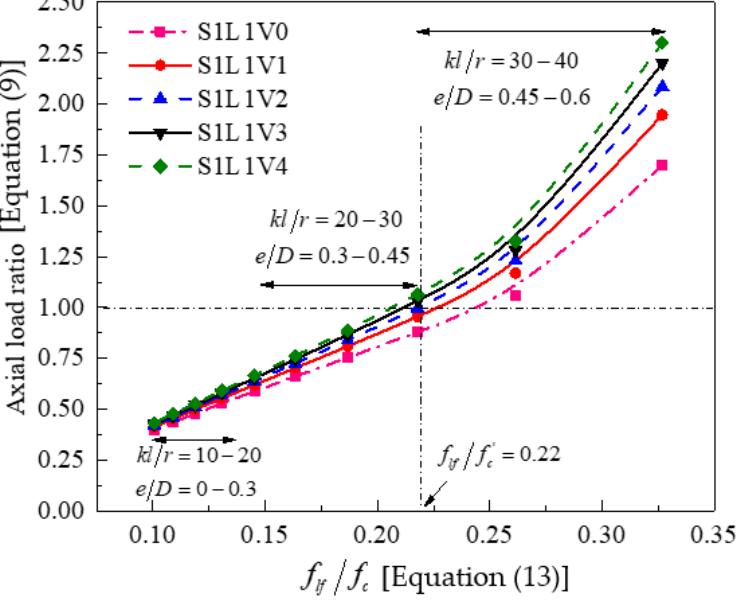
Figure 8. Relationship between effective confinement pressure ratio and confined strength ratio.